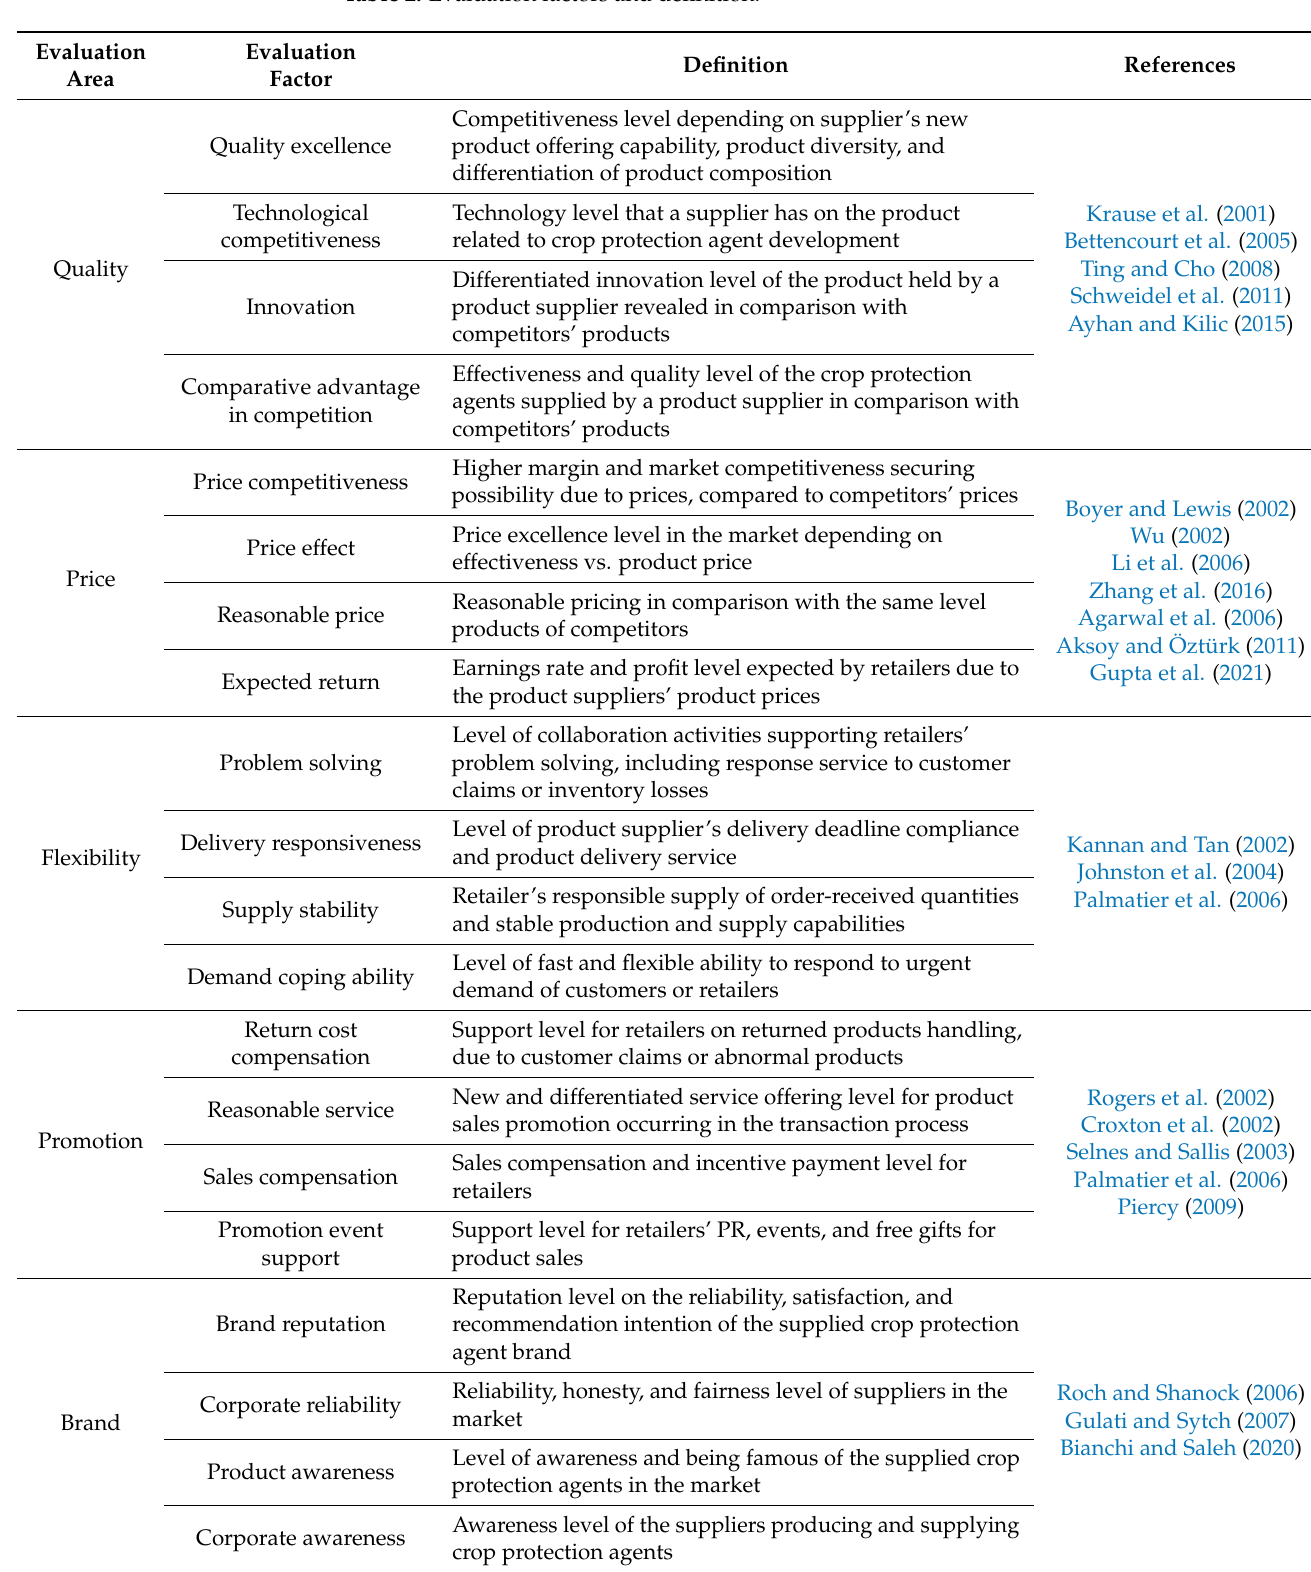
Table 2. Evaluation factors and